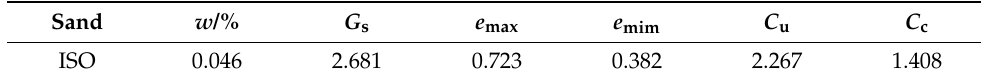
Figure 2. Particle size distribution curve of the ISO sample. Table 1. Physical index of sands.